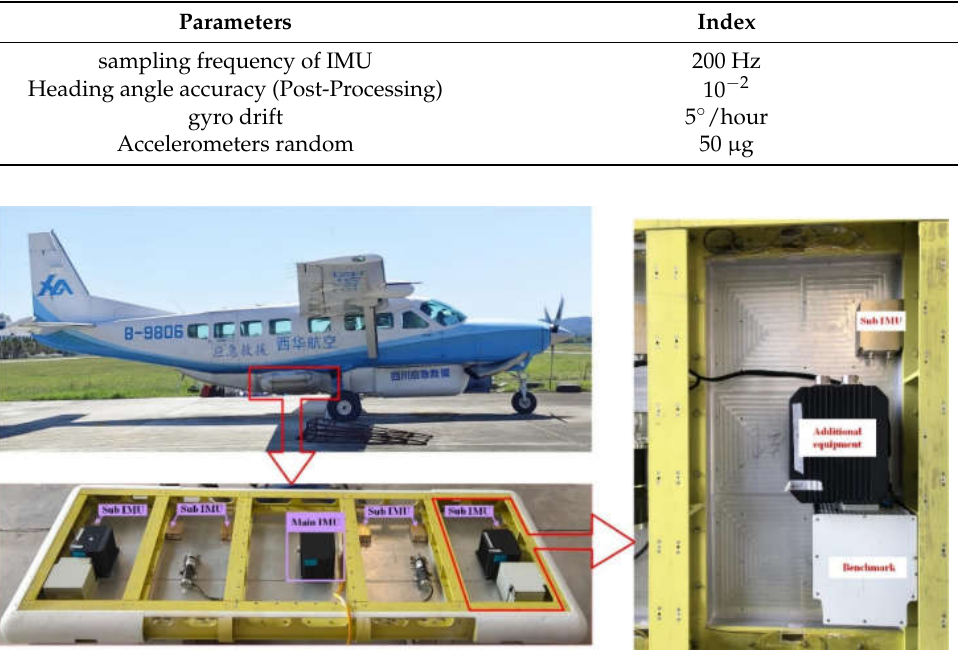
Figure 4. The whole flight experiment process.